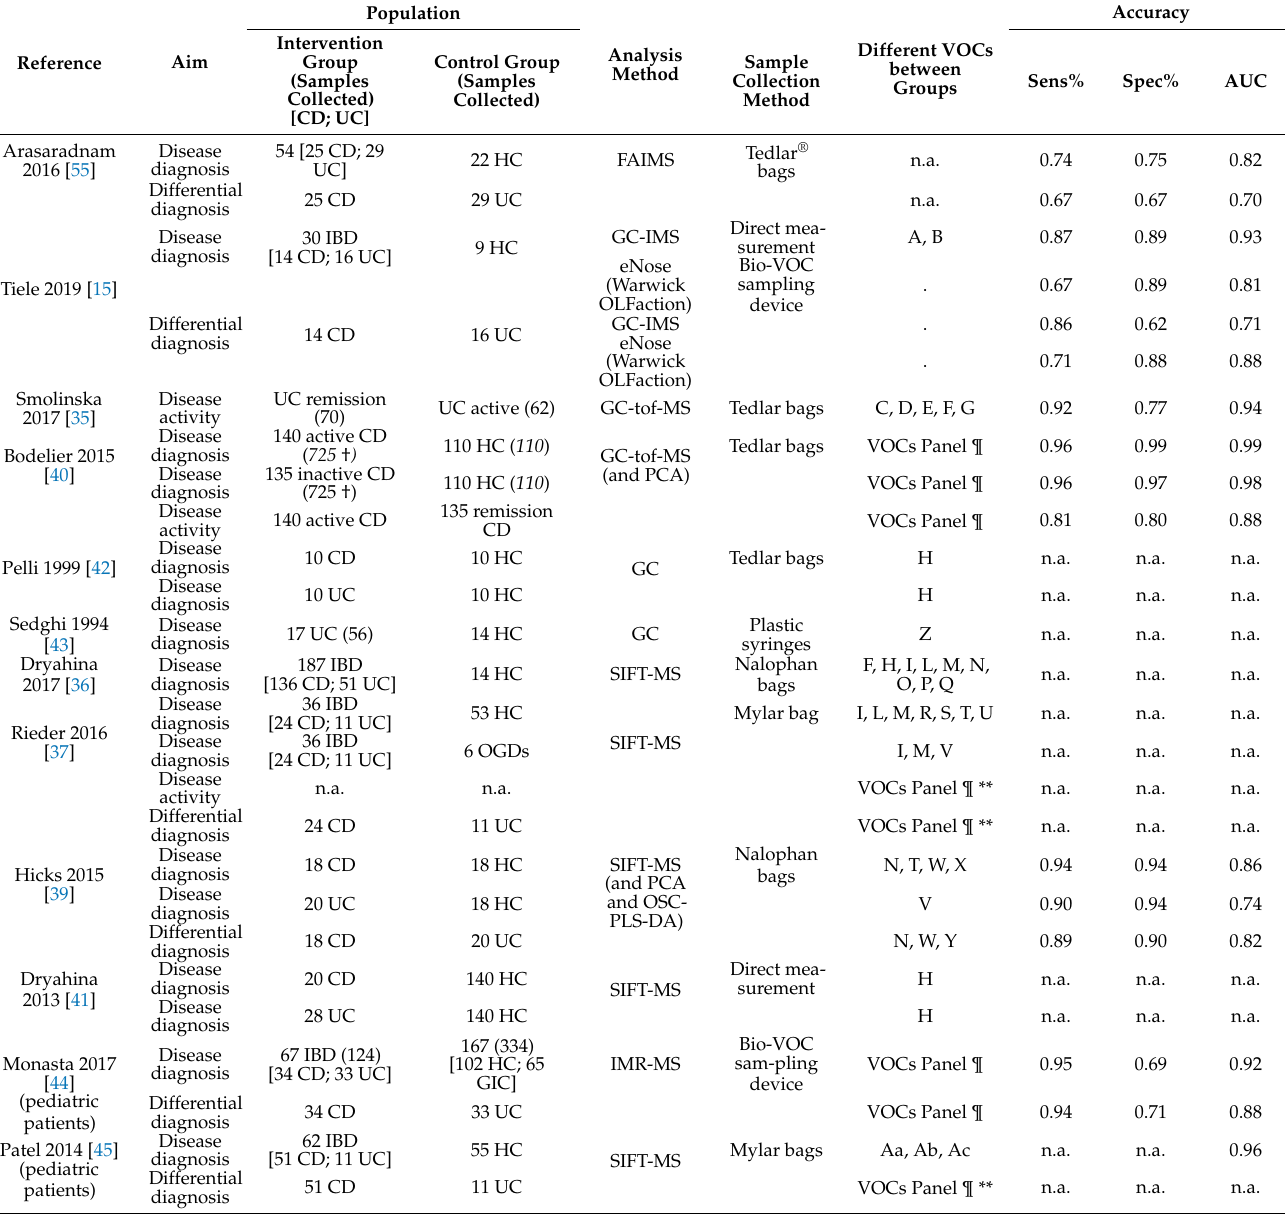
Table 5. Breath test VOCs and IBD diagnosis and activity